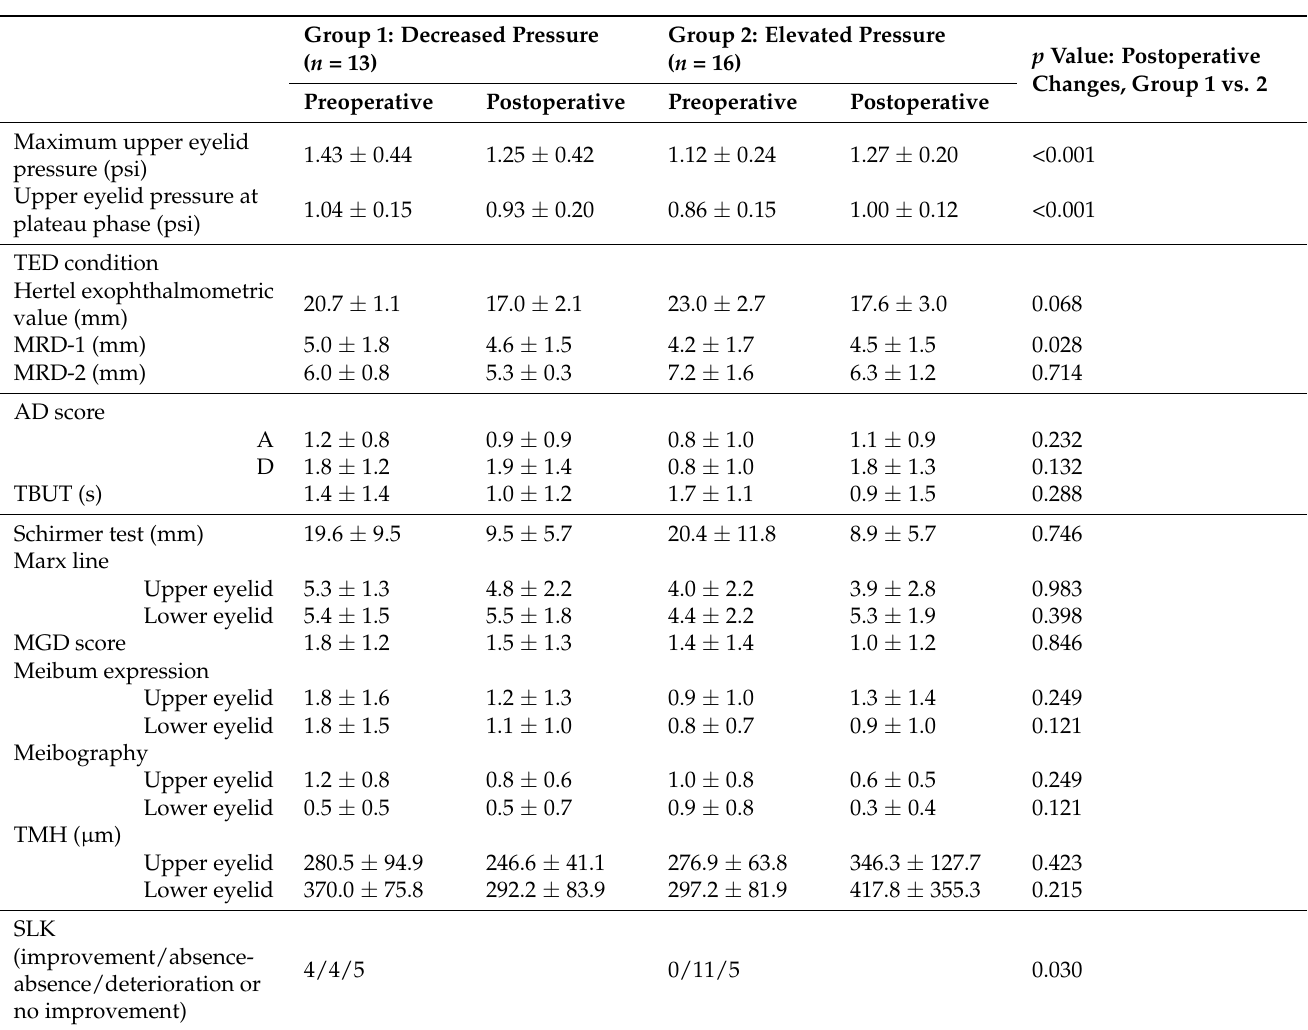
Table 3. Comparison of measurement results between the